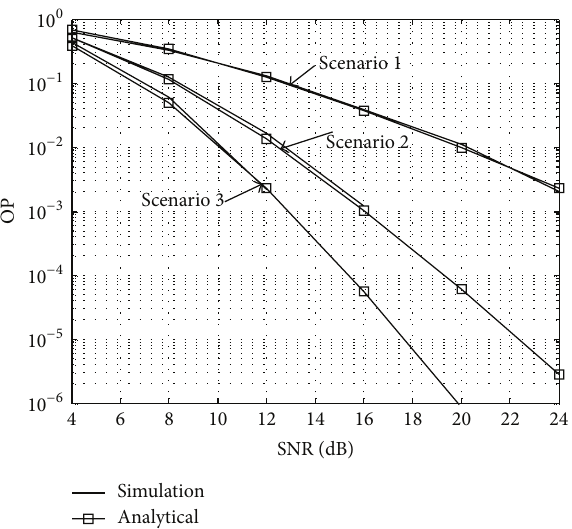
Figure 2: The OP performance over 𝑁 -Nakagami fading channels < 𝛾 when 𝛾 𝑇 . th